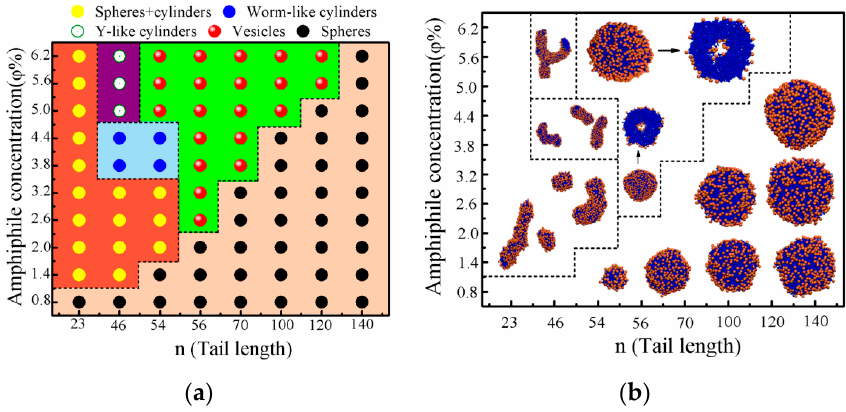
Figure 3. ( a ) Morphological phase diagram; and ( b ) typical snapshots of aggregates formed by the P n –H amphiphiles depending on ϕ and n at T ∗ = 1.2. The color scheme and the meaning of arrows